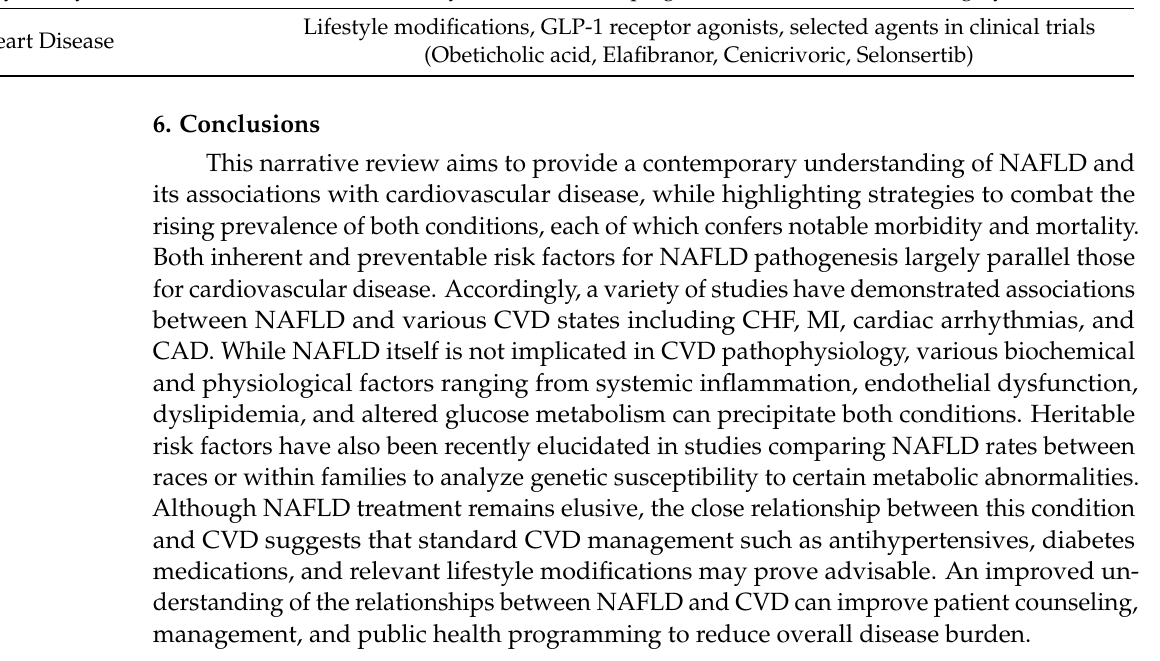
Table 2. Summary of Co-morbidities in NAFLD and preventives to lower ASCVD. Cardiovascular Co-morbidities in NAFLD and Preventive Strategies to Lower ASCVD Lifestyle modifications, RAAS inhibitors, selected agents in clinical trials (Obeticholic Hypertension acid, Pegbelfermin, Elafibranor) Diabetes Mellitus Metabolic Syndrome Coronary Artery Disease Heart